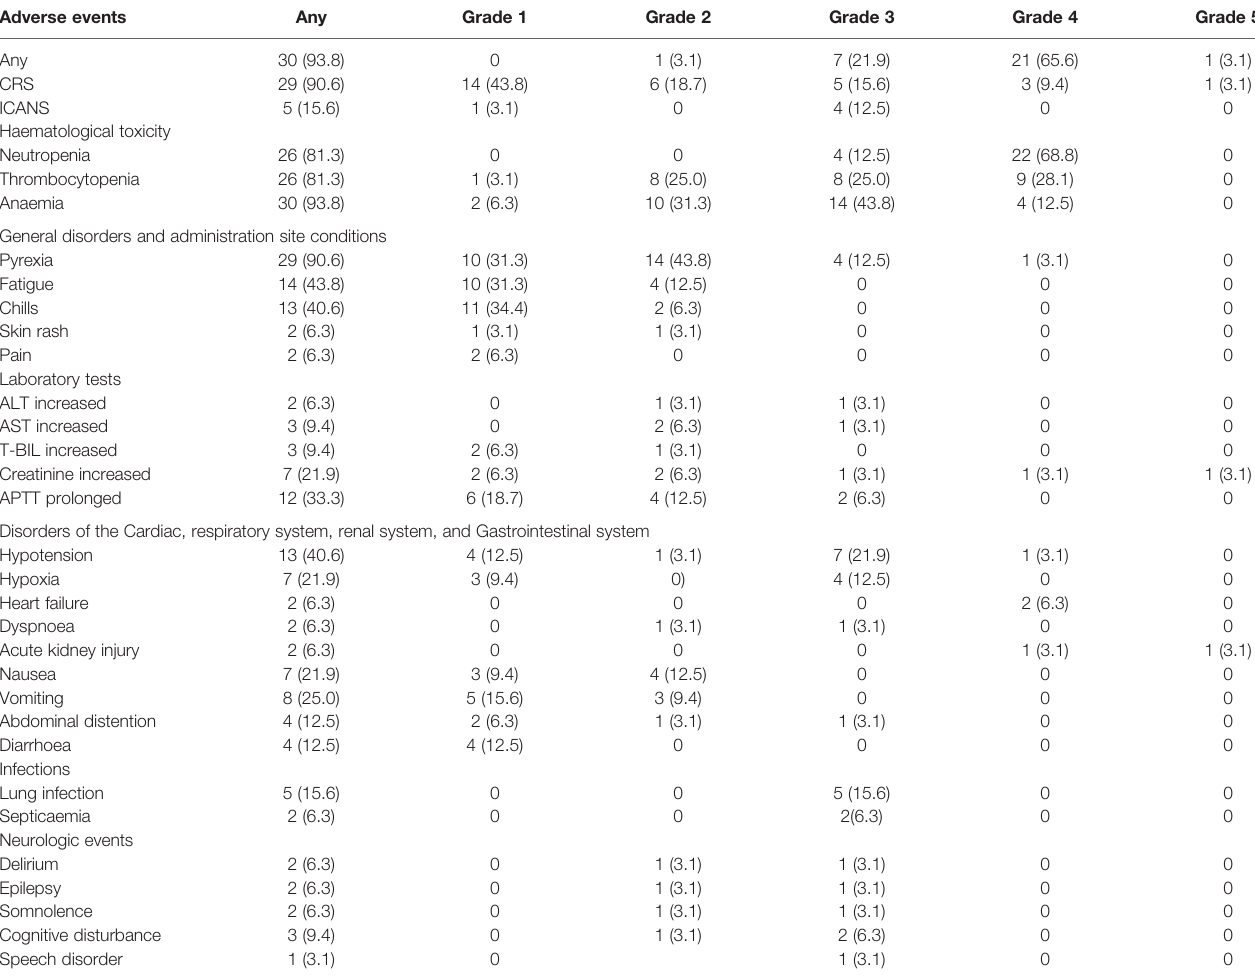
TABLE 2 | Adverse among All 32 Treated